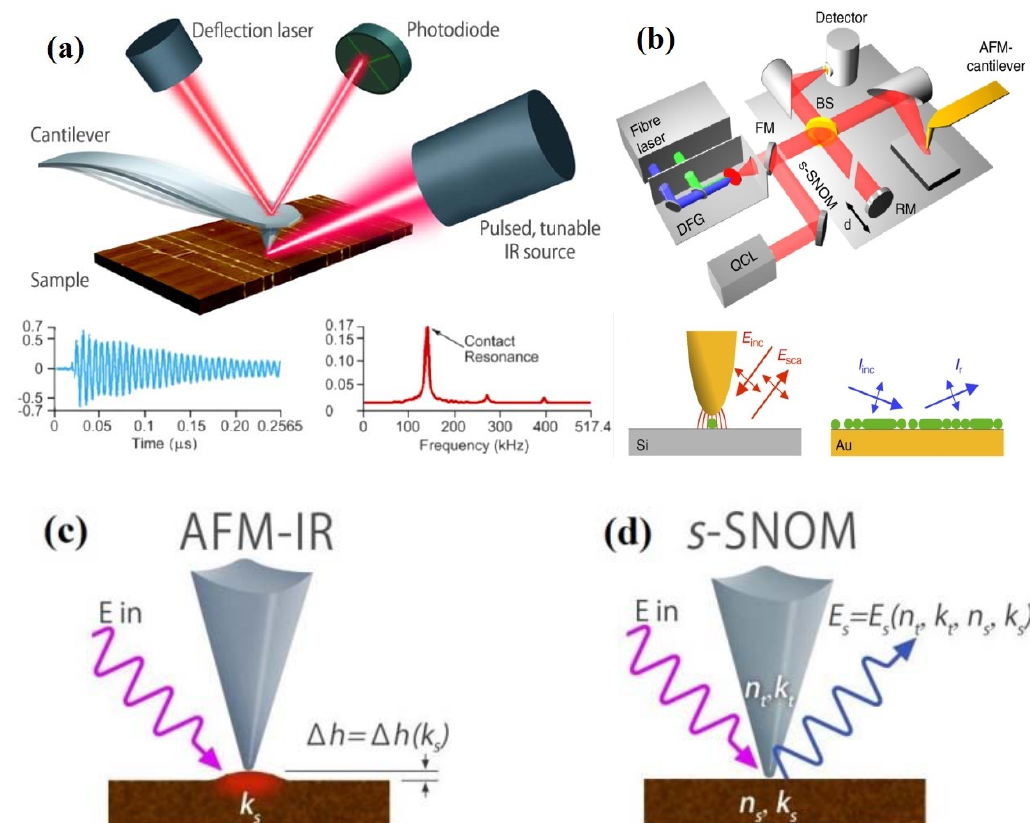
Figure 1. Schematic diagram of AFM-IR ( a ), IR s-SNOM ( b ), and their working principles ( c , d ). Reproduced with permission from [37,43]. Copyright Macmillan Publishers Limited, 2013; Copyright Microscopy Society of America; Copyright Anasys Instruments (Now Bruker Corporation), 2015.